Question: Express in one sentence what the figure is showing.
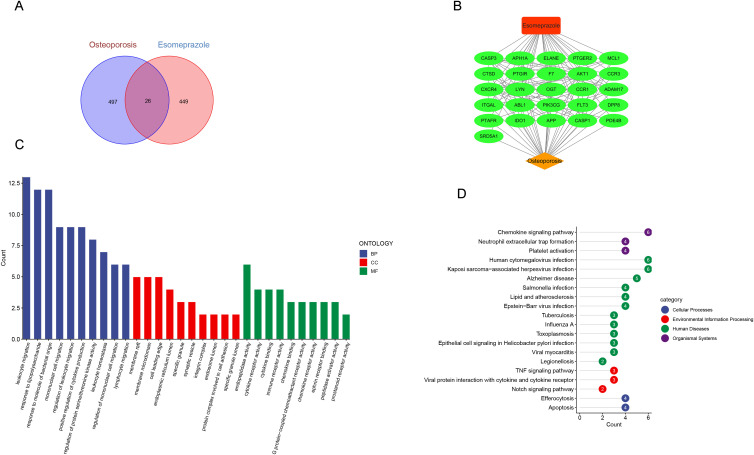
Answer: Identification of common targets and enrichment analysis between esomeprazole and osteoporosis. (A) Venn diagram showing the overlapping genes between predicted targets of esomeprazole and DEGs associated with OP. (B) Network visualization of shared targets between esomeprazole and OP. Green circles represent genes, the orange quadrilateral represents OP, and red-bordered nodes indicate esomeprazole. (C) GO enrichment analysis of the 26 shared genes. The bar chart displays the number of genes enriched in each term across three categories: BP, CC, and MF. (D) KEGG pathway enrichment analysis of shared genes. The lollipop chart indicates the number of enriched genes in each pathway, with different colors representing distinct KEGG categories.